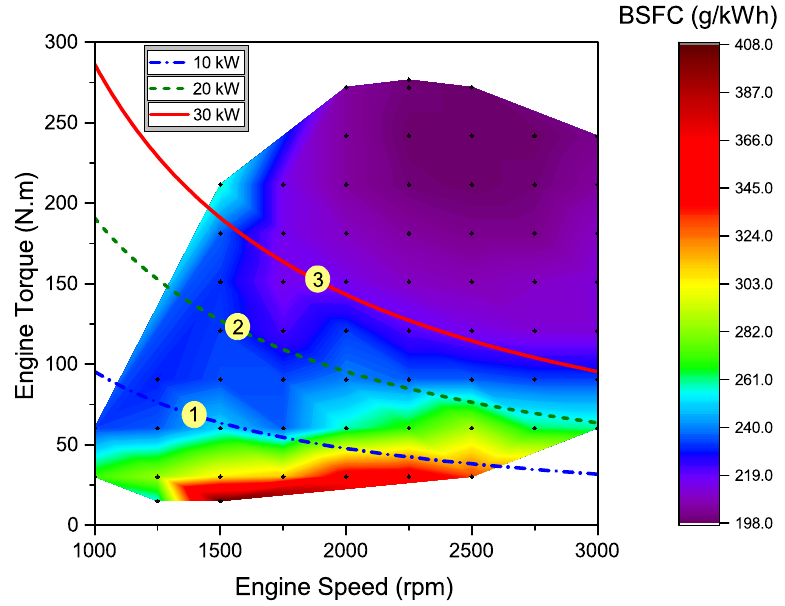
Figure 4. BSFC map (g/kWh) of the GM Z19DTH CI (diesel) engine. The data from [40] was used to generate this figure.